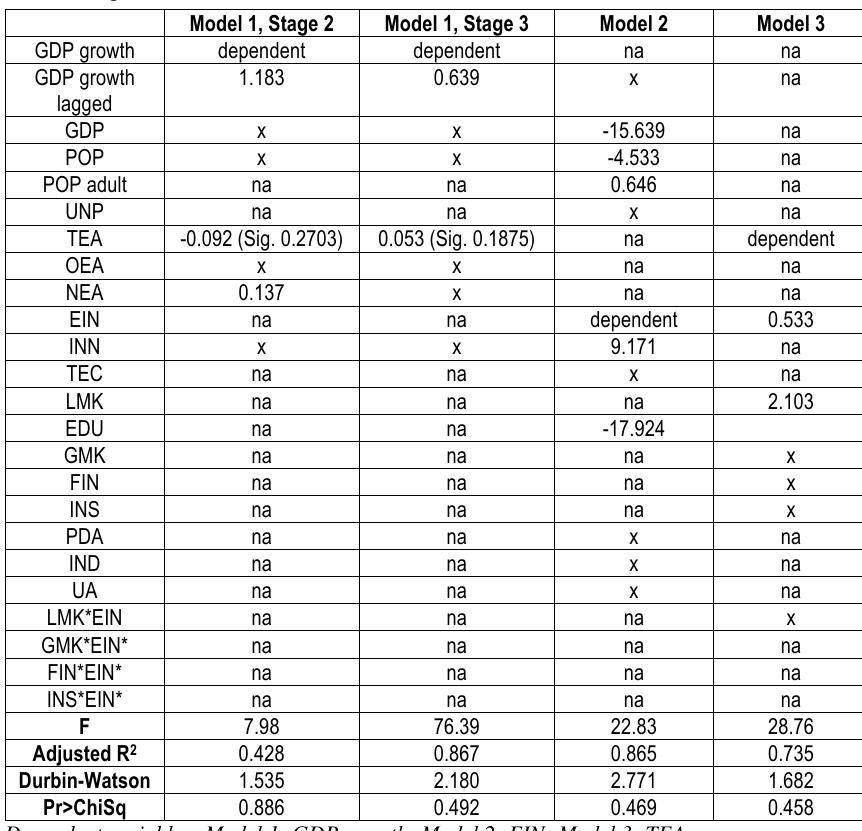
Table 2 . Regression